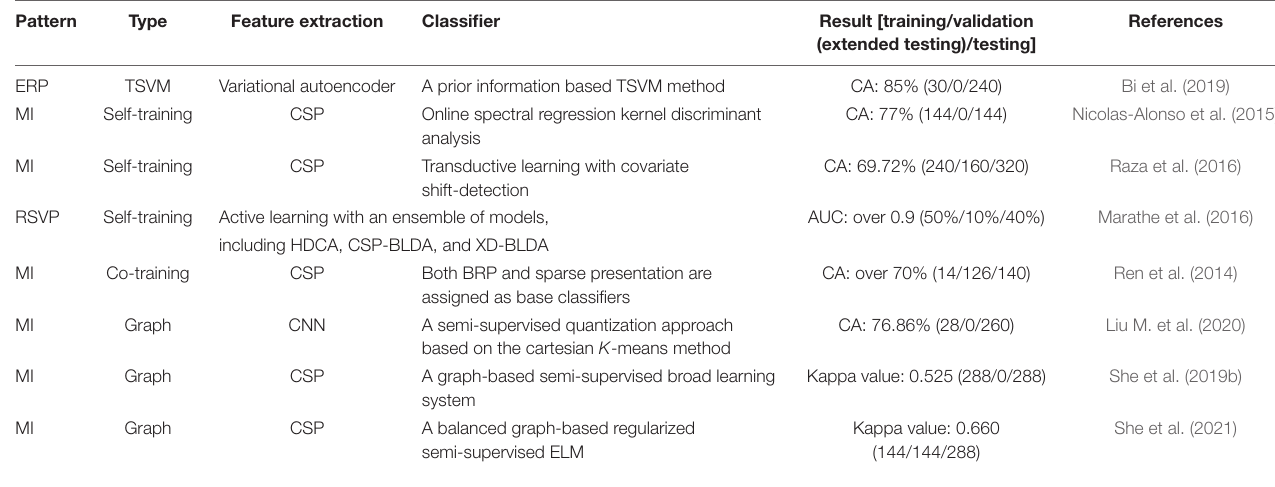
TABLE 3 | Summary of representative SSL